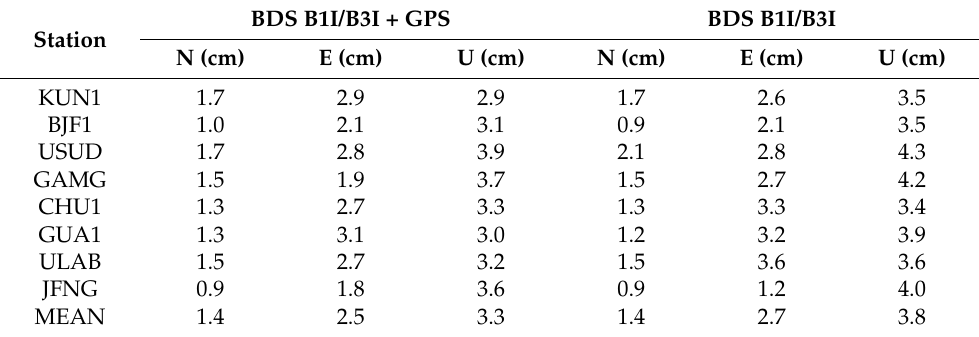
Figure 8. ( a ) Static position errors RMS using PPP-B2b BDS B1I/B3I; ( b ) static position errors RMS using PPP-B2b BDS B1C/B2a. Table 6. Mean RMS values of PPP-B2b static positioning of each station using